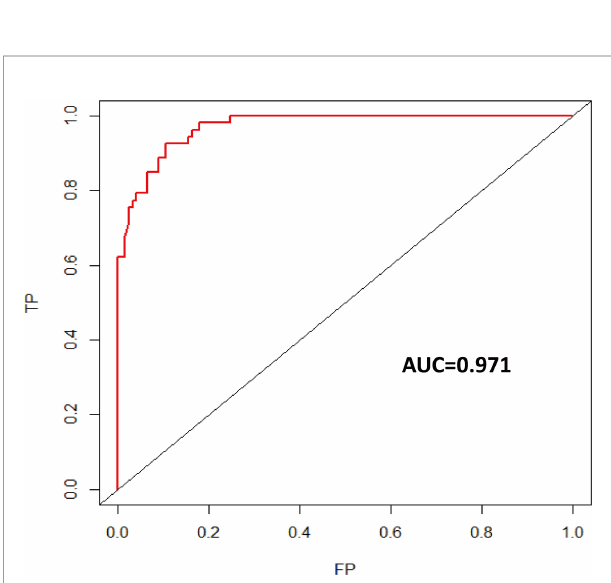
FIGURE 1 | A nomogram for predicting the risk of short-term recurrence of glioma.